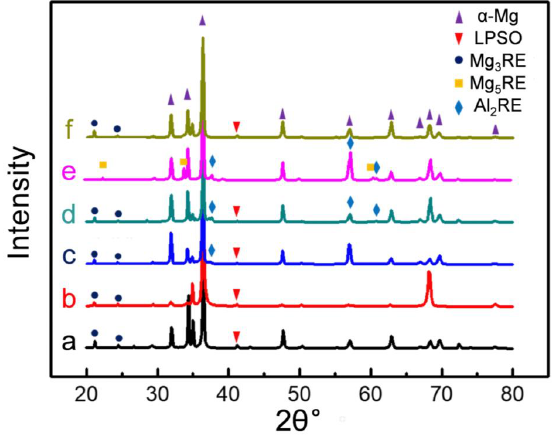
Figure 5. XRD patterns of the as-cast alloys: ( a – d ) 0.5Zn-xAl (x = 0, 0.2, 0.5, and 1.0); ( e ) 0Zn-1.0Al Fig. 5. XRD patterns of the as-cast alloys: (a-d) 0.5Zn-xAl (x = 0, 0.2, 0.5, and 1.0); (e) 0Zn-1.0Al and (f) 0.15Zr. and ( f ) 0.15Zr.